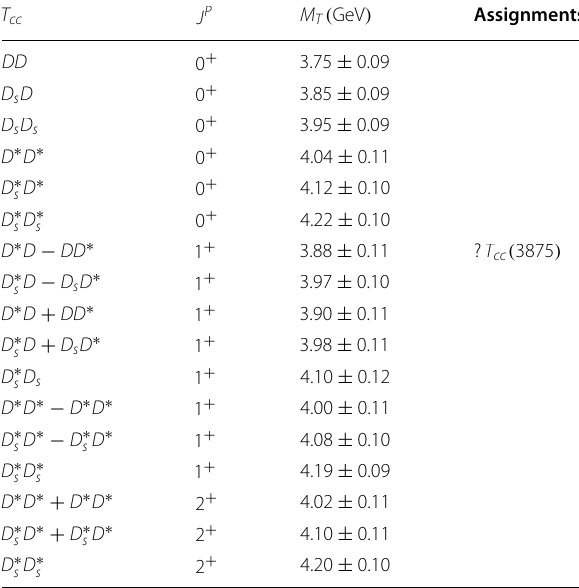
Table 3 The possible assignments of the ground state doubly‑ charm molecular states, the isospin limit is implied. The molecular states with the constituents D ∗ and D ∗ s are taken from Ref.